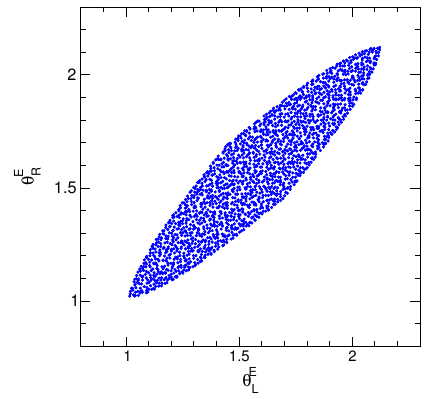
Figure 3 . Allowed region for the mixing angles in the heavy charged sector for a benchmark scenario speci(cid:12)ed in eqs.